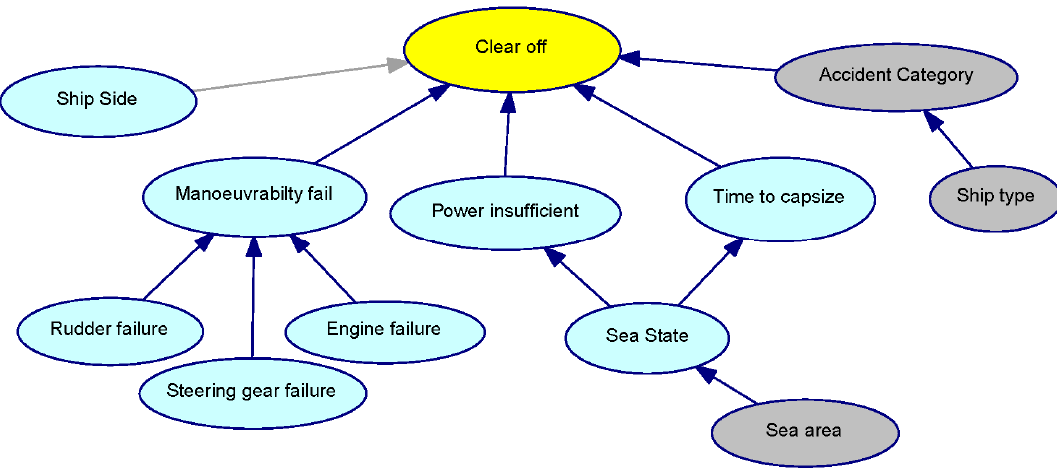
Figure A6. A Bayesian network for lifeboat lowering in both flooding and fire/explosion accidents (05).